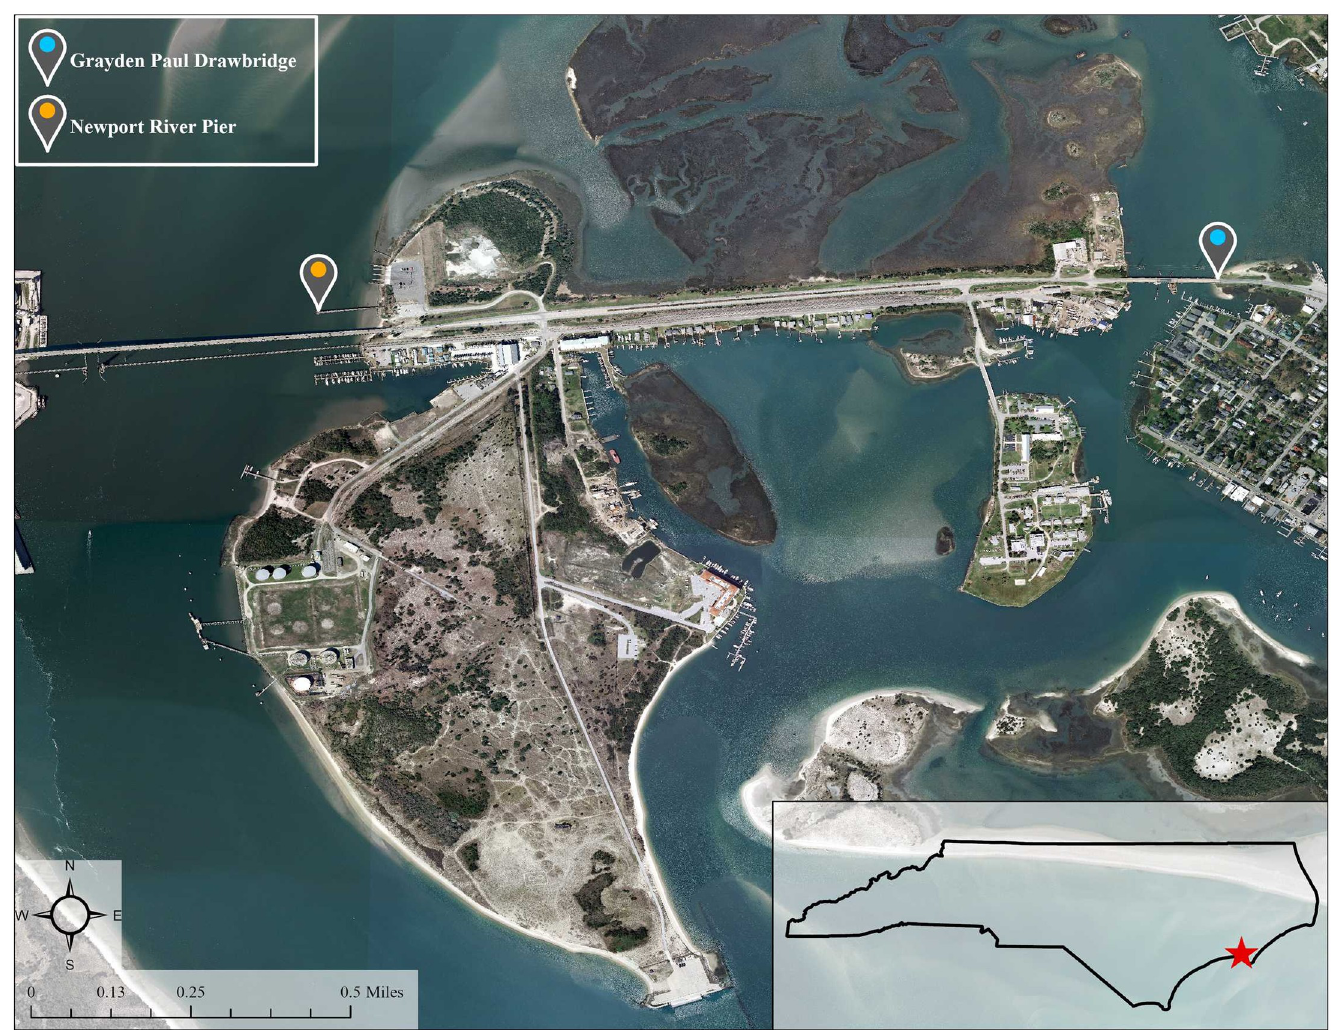
Fig 1. Study sites in Carteret County. Source: U.S. Geological Survey, National Geospatial Technical Operations Center, 20201211, USGS National Boundary Dataset (NBD) in North Carolina 20201211 State or Territory Shapefile: U.S. Geological Survey.